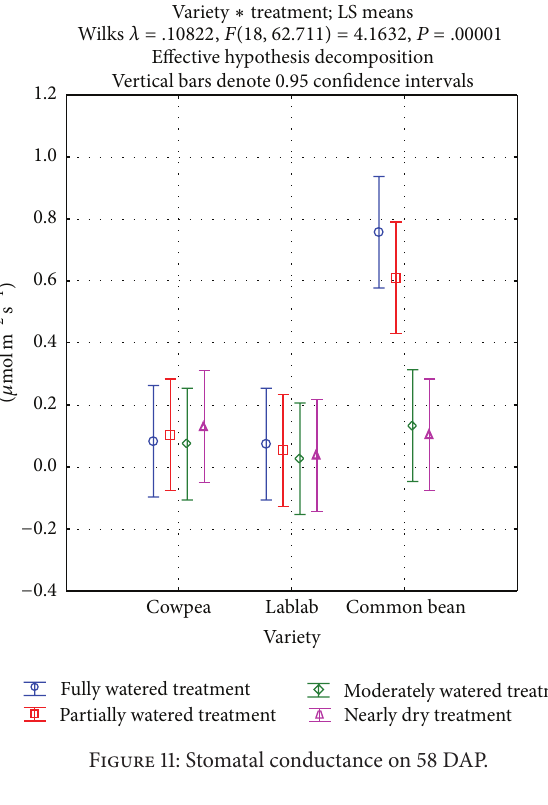
Effective hypothesis decomposition Vertical bars denote 0.95 confidence intervals